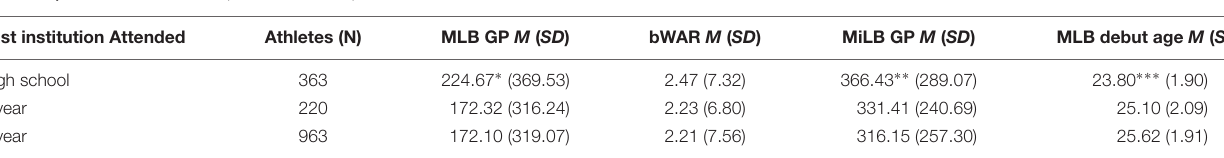
TABLE 3 | MLB and MiLB descriptive statistics – pitchers.